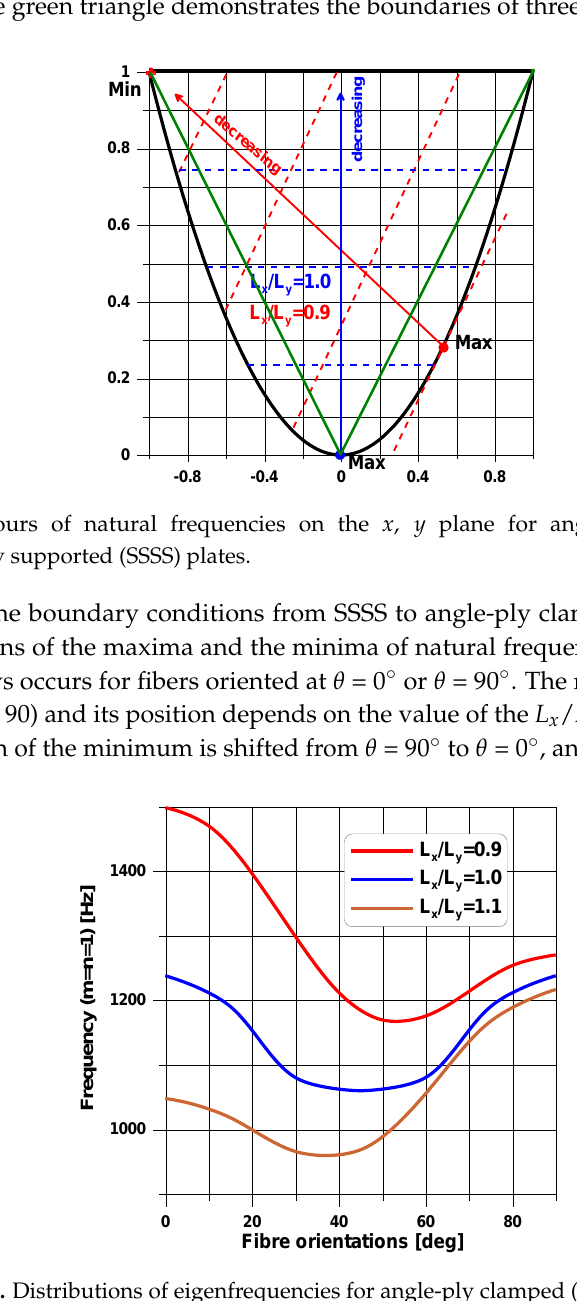
Figure 5. Distributions of eigenfrequencies for angle-ply simply supported (SSSS) plates.